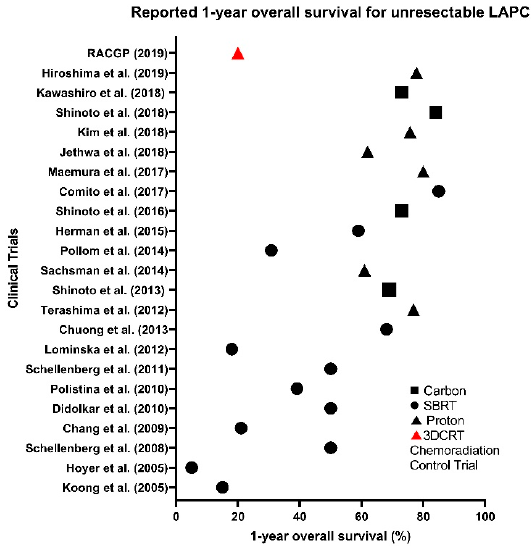
Figure 2. Reported 1-year overall survival (OS) rate for unresectable LAPC across SBRT ( ● ), proton ( ▲ ) and carbon ( ∎ ) clinical trials compared to 3D conformal chemoradiation ( ▲ ) control trial.